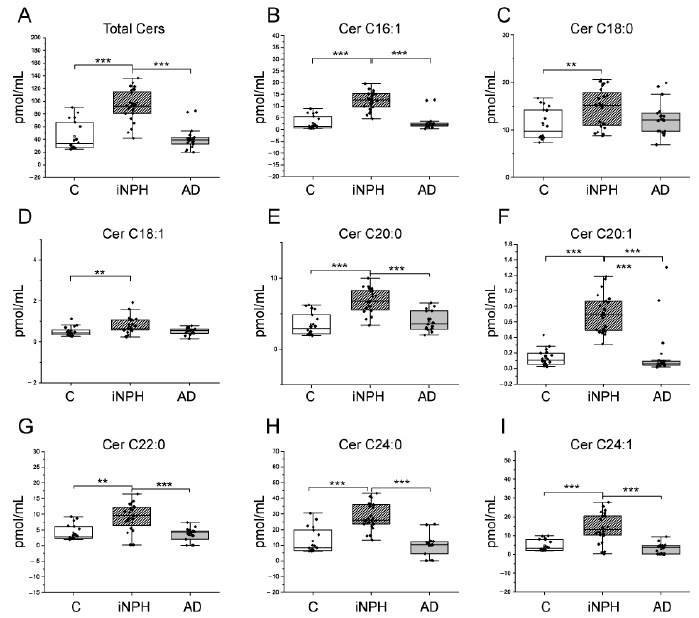
Figure 1. Box plots of CSF ceramide (Cer) species changed in iNPH and AD patients compared to C subjects. ( A ) Total Cers, ( B ) Cer C16:1, ( C ) Cer C18:0, ( D ) Cer C18:1, ( E ) Cer C20:0, ( F ) Cer C20:1, ( G ) Cer C22:0, ( H ) Cer C24:0, ( I ) Cer C24:1.